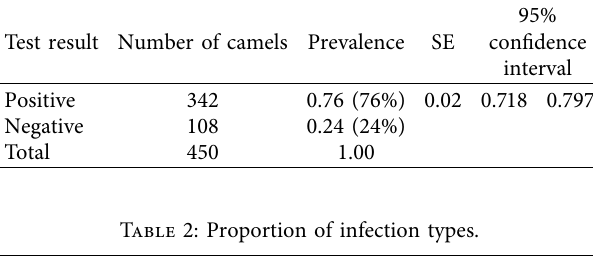
Table 1: Prevalence of gastrointestinal parasites in camels in Zone 3 of the Afar Region.